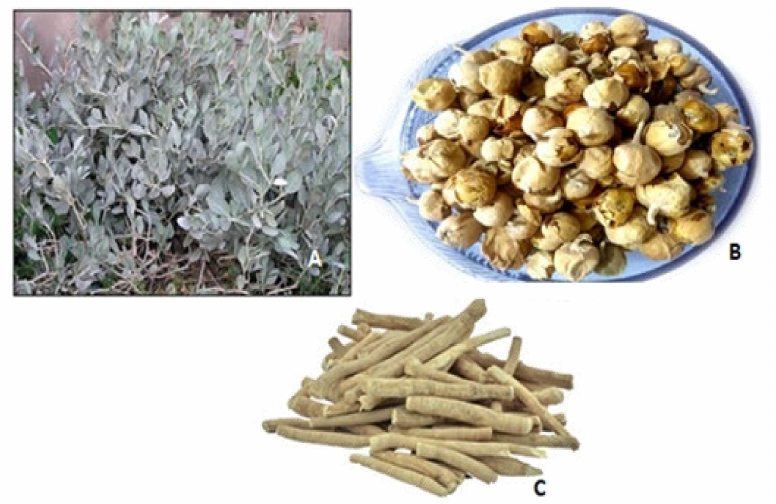
Figure 1. W. coagulans plant. ( A ): Leaves, ( B ): Fruits, ( C ):